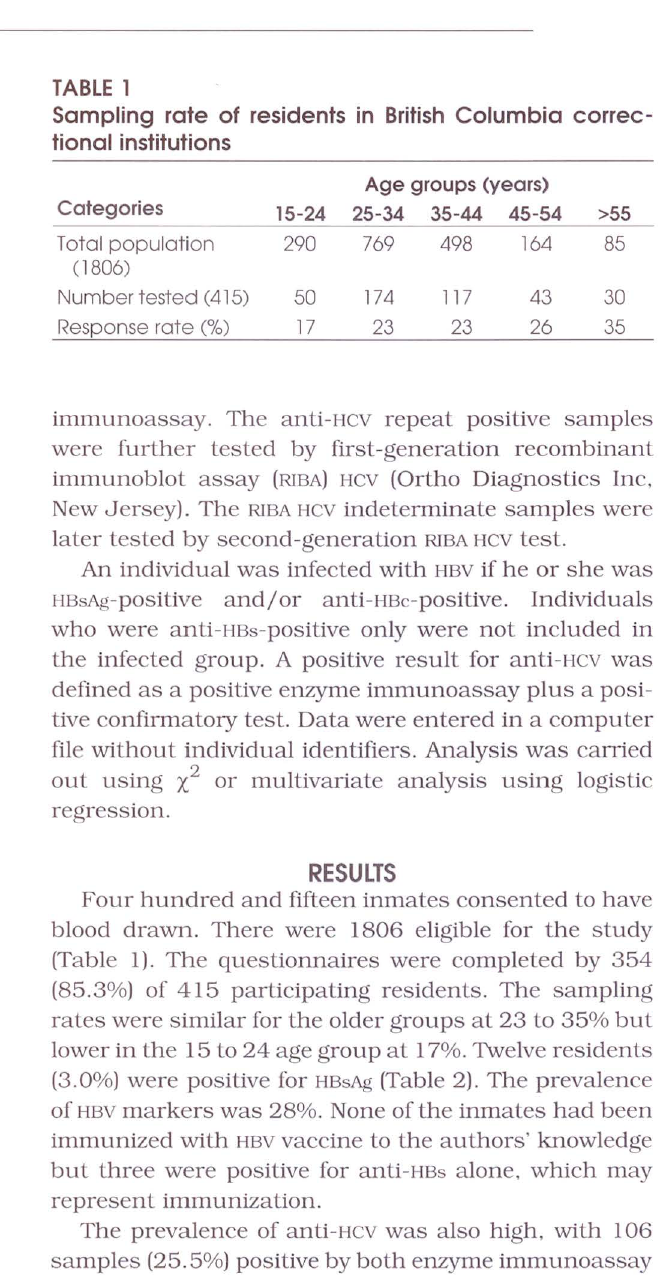
Sampling rate of residents in British Columbia